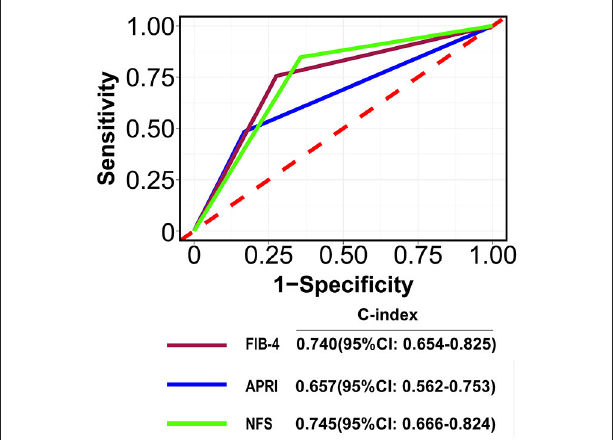
FIGURE 2 | The area under curves for predicting the mortality at 28-days. A: FIB-4; B: APRI; C: NFSFIB-4, Fibrosis-4; APRI, Aspartate Aminotransferase -to-platelet ratio index; NFS: NAFLD fibrosis